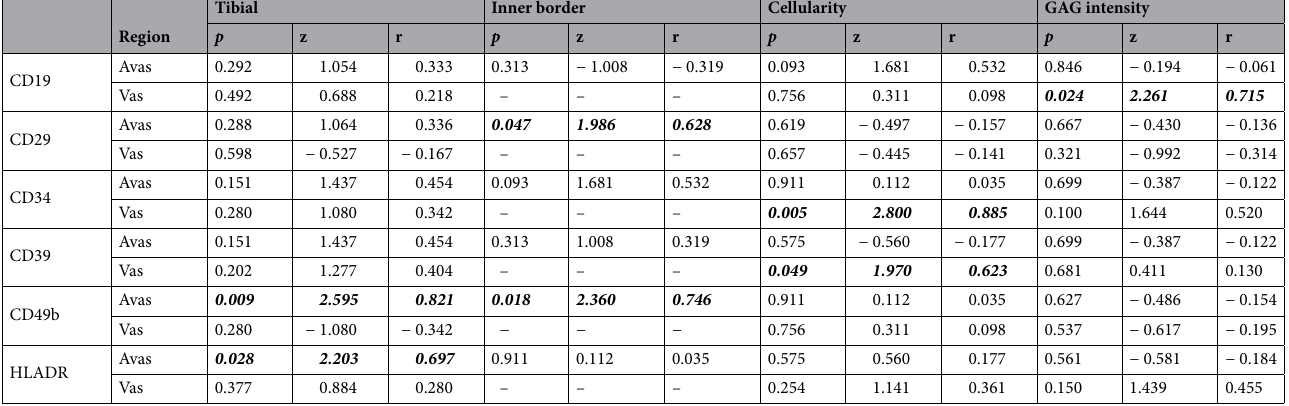
Table 2. Correlation between surface markers and histology scores. Jonckheere-Terpstra test: Avascular region (marked with grey background); vascular region (marked with white background). Only values that have significant differences are shown in the Table; see the full dataset in the Supplementary Table 1. The significant values are highlighted in bold and